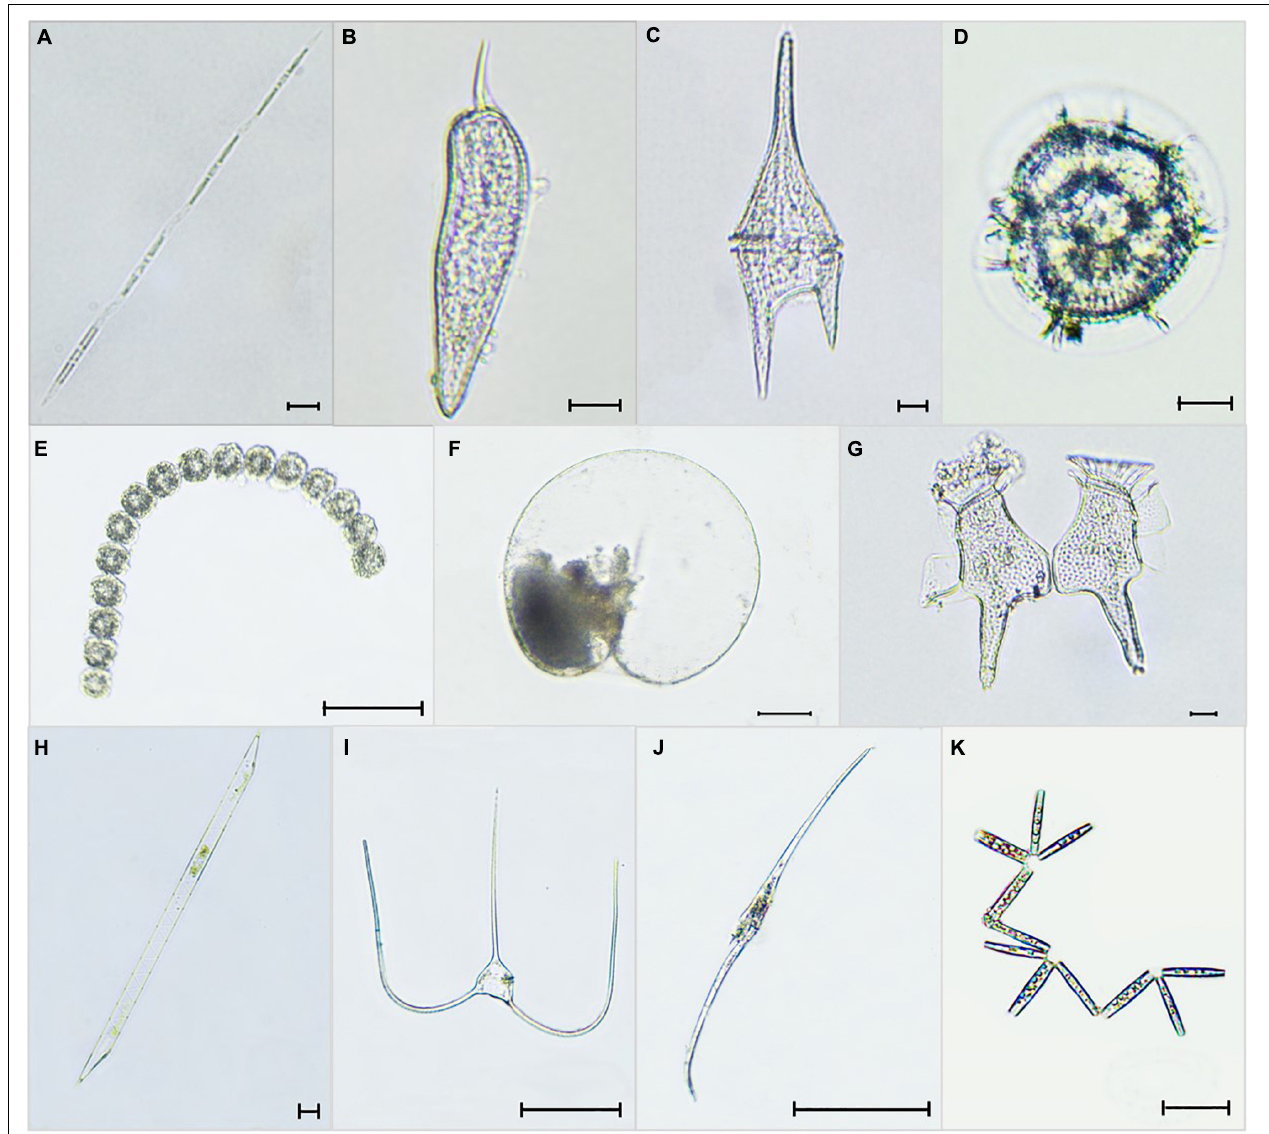
FIGURE 5 | Selected micrographs of the phytoplankton observed in the five bays of E. Visayas, 2020–2021: (A) Pseudo-nitzschia sp. (B) Prorocentrum sigmoides , (C) Ceratium furca ( Tripos furca ), (D) Pyrodinium bahamense , (E) Gymnodinium catenatum , (F) Noctiluca scintillans , (G) Dinophysis caudata , (H) Rhizosolenia fallax , (I) Ceratium trichoceros ( Tripos trichoceros ), (J) Ceratium inflatum ( Tripos inflatus ), and (K) Thalassionema nitzschioides . Scale Bars: (A–D,F–H) = 10 µ m; (E, I–K) = 100 µ